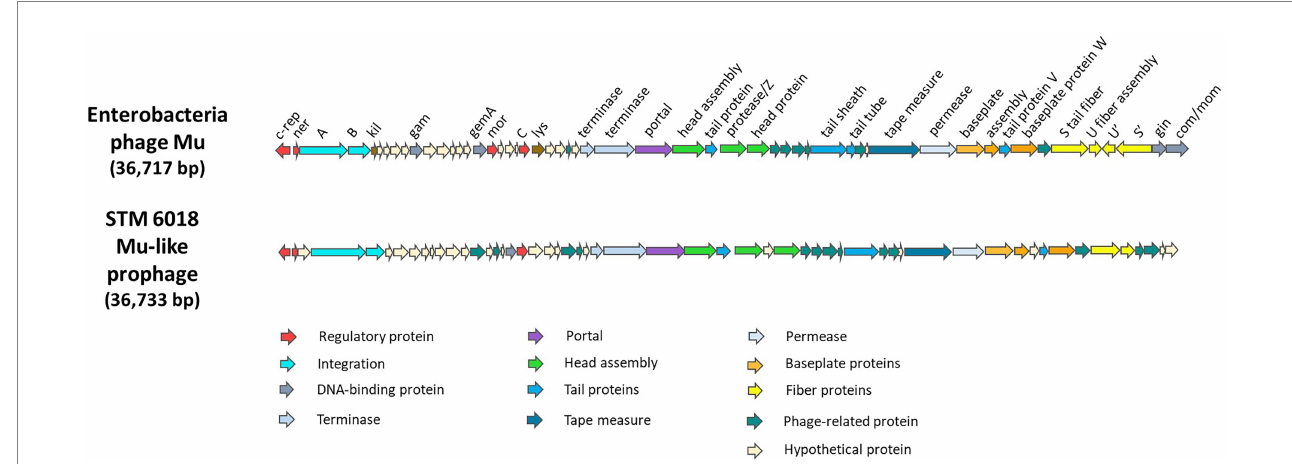
FIGURE 2 Genes and genome organization of Enterobacteria phage Mu (Morgan et al., 2002) and the Mu-like phage found in STM